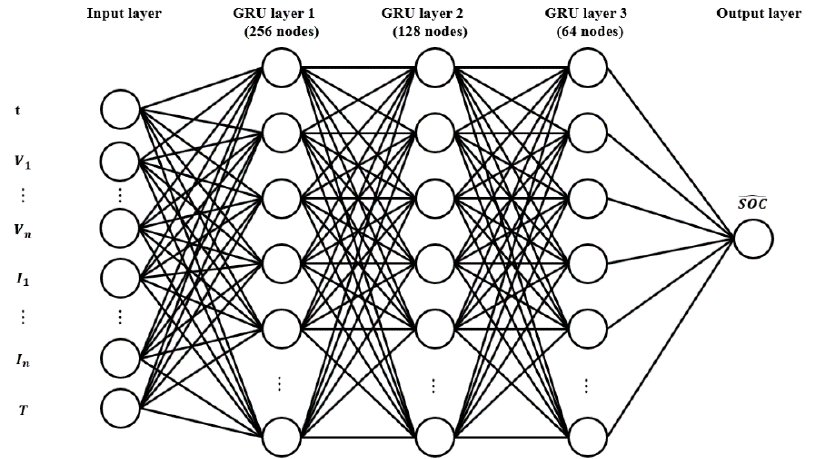
Figure 10. Structure of the GRU for SOC estimation.